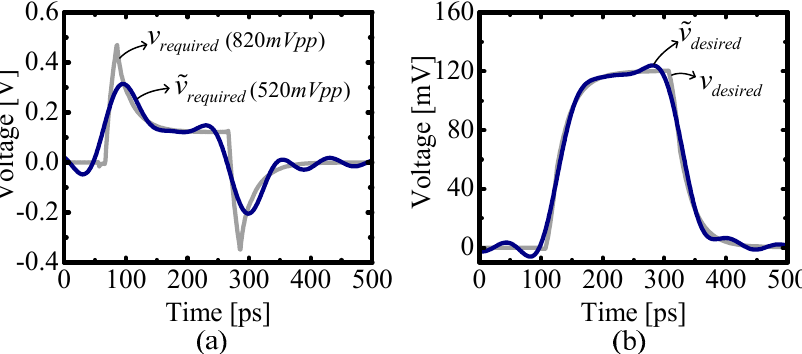
Figure 2. Proposed waveform comparison. ( a ) Suitable input waveforms and ( b ) desired output waveforms. The gray line is the unrelaxed waveform and the blue solid line is the relaxed waveform.